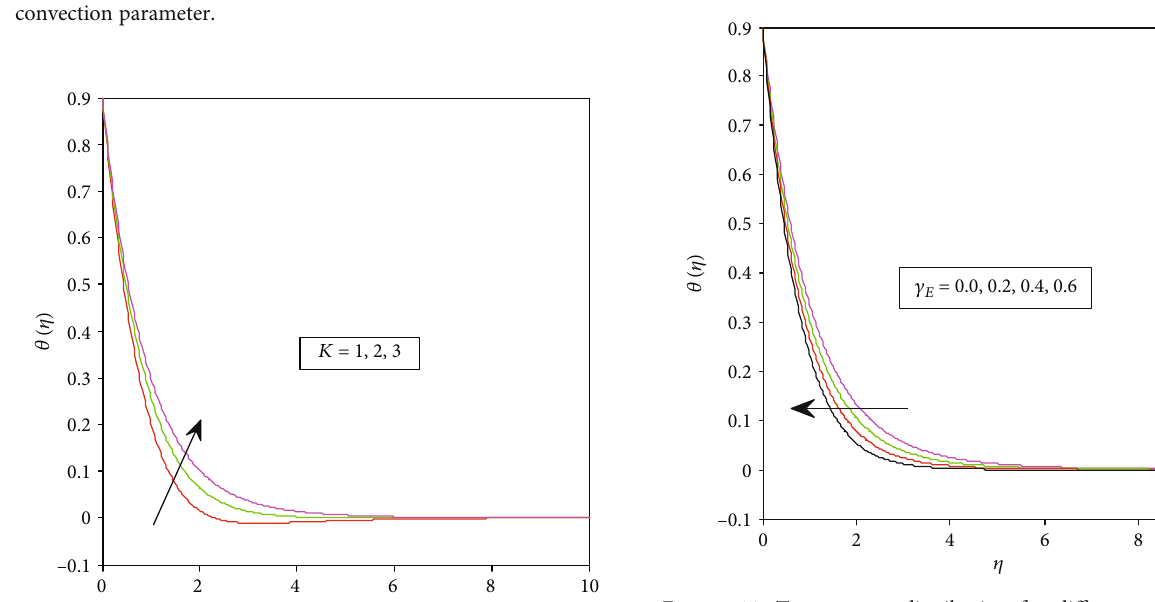
Figure 11: Temperature distribution for di ff erent values of the relaxation time of the heat fl